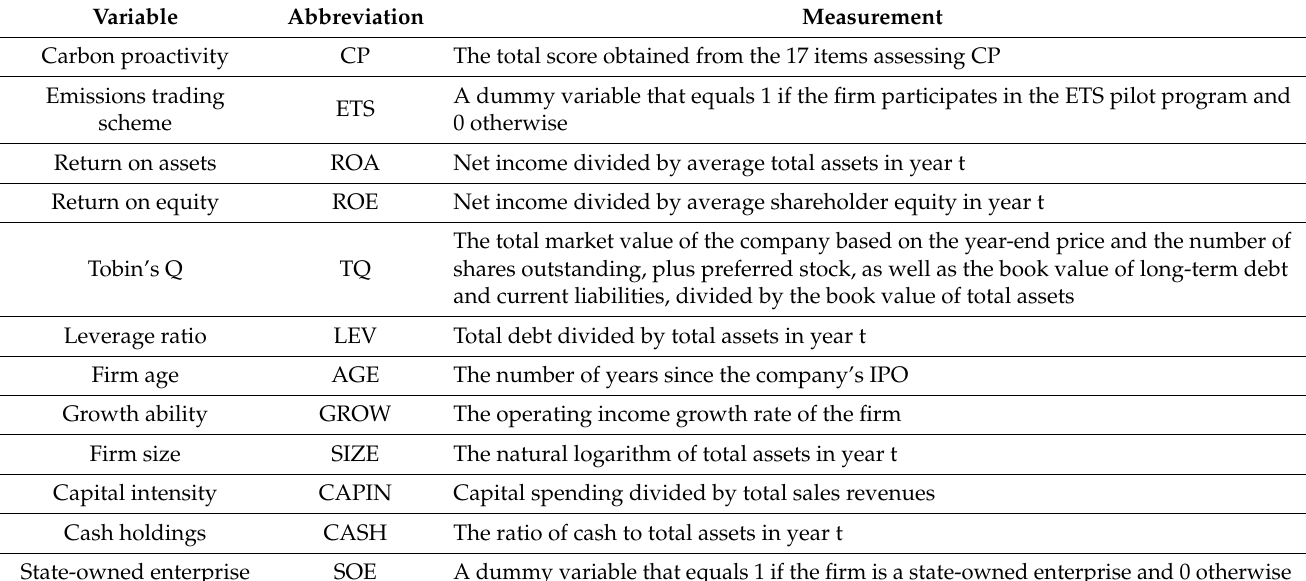
Table 3. Definition and Measurement of